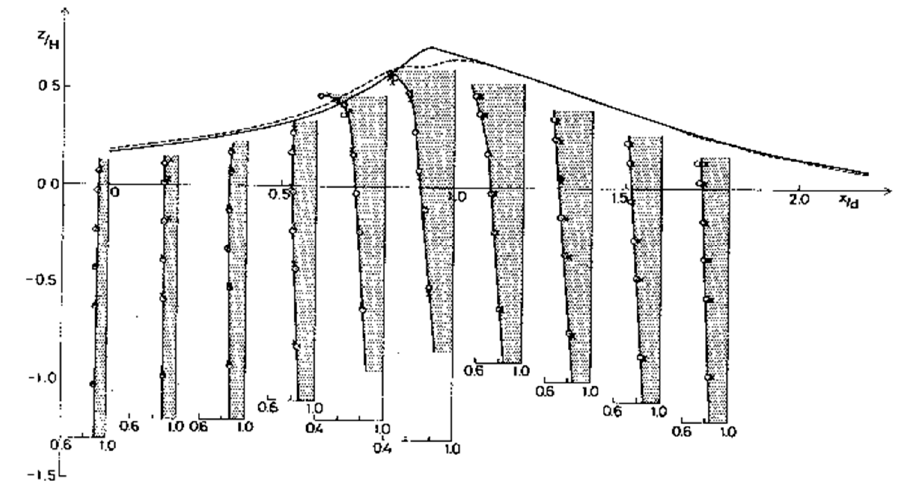
Figure 12. Example of the distribution of velocity components on a vertical plane parallel to the diametrical plane of wedge-shaped model [10].